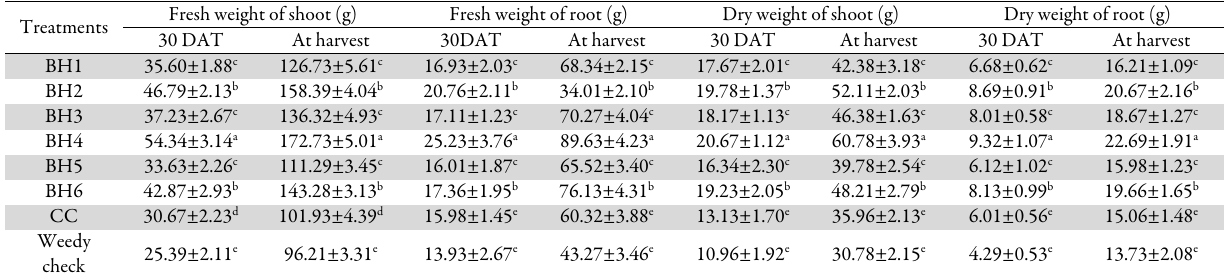
Table 1. The growth parameters of maize after application of various treatments Treatments